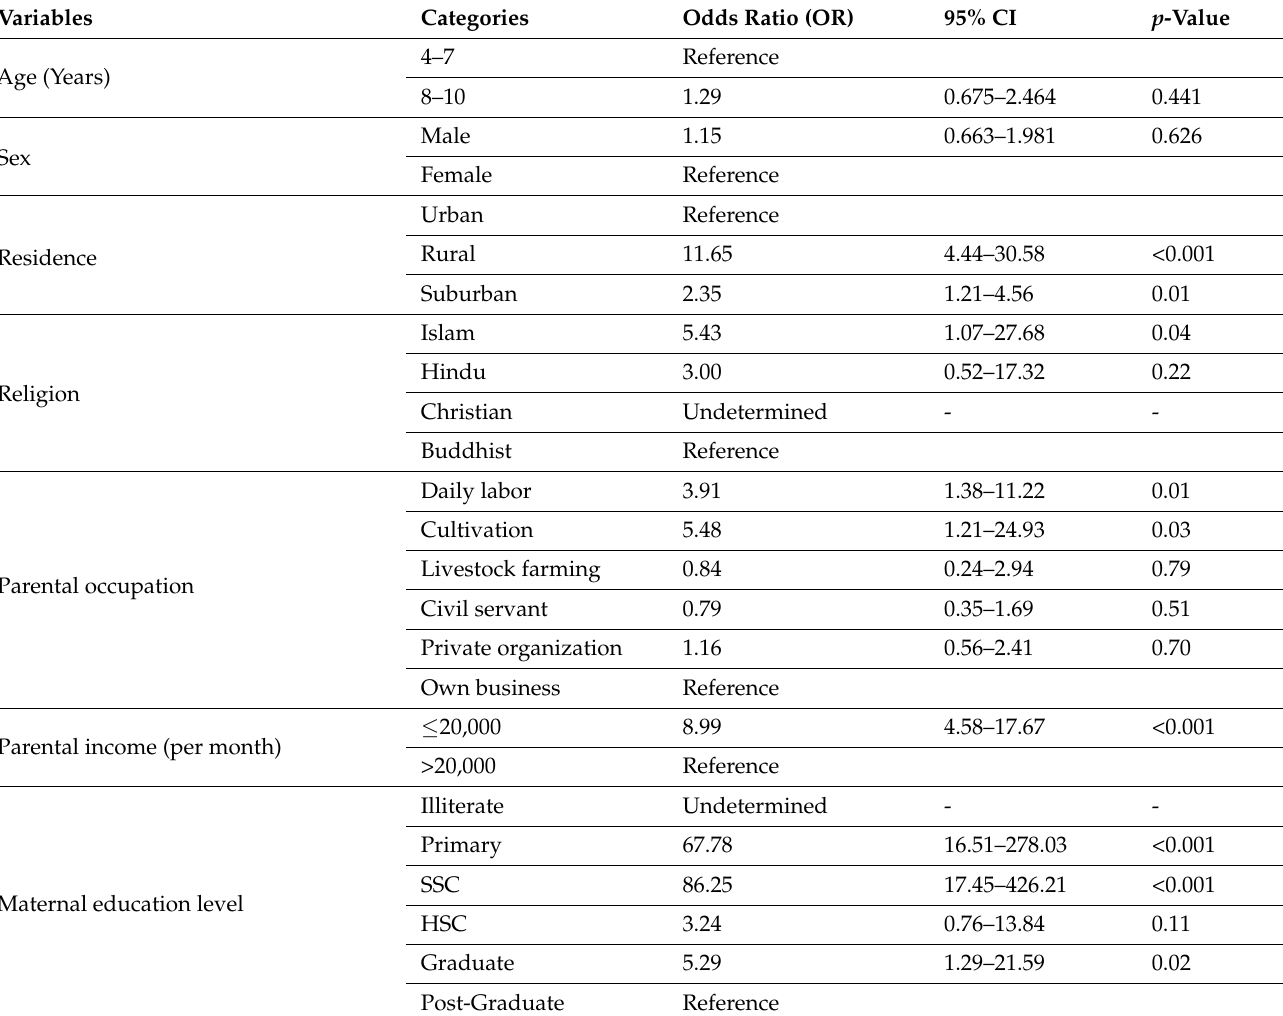
Table 4. Sociodemographic factors * associated with the occurrence of dental caries in pediatric patients.